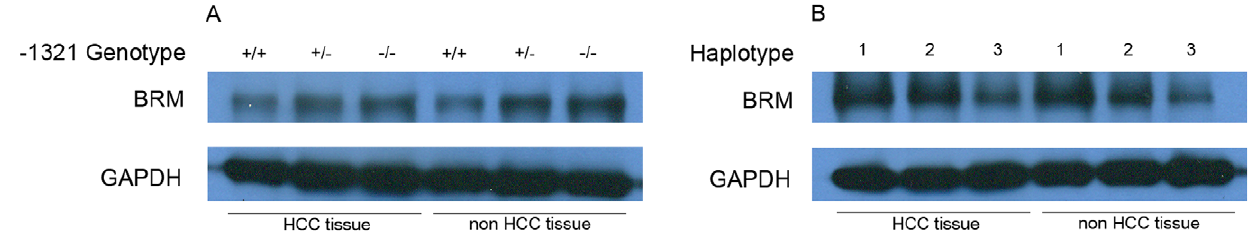
Figure 3. Western blot analysis of BRM expression in HCC tissue and adjacent non-tumor tissues. (A) BRM expression for different BRM- 1321 genotypes. (B) BRM expression for different haplotypes. Haplotype # 1: 2 1321 del/del-741 ins/ins, Haplotype # 2: 2 1321 del/del-741 del/del, Haplotype # 3: 2 1321 ins/ins-741 ins/ins.